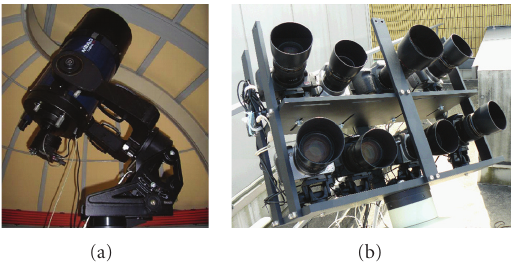
Figure 1: AROMA-N (a) and AROMA-W (b).